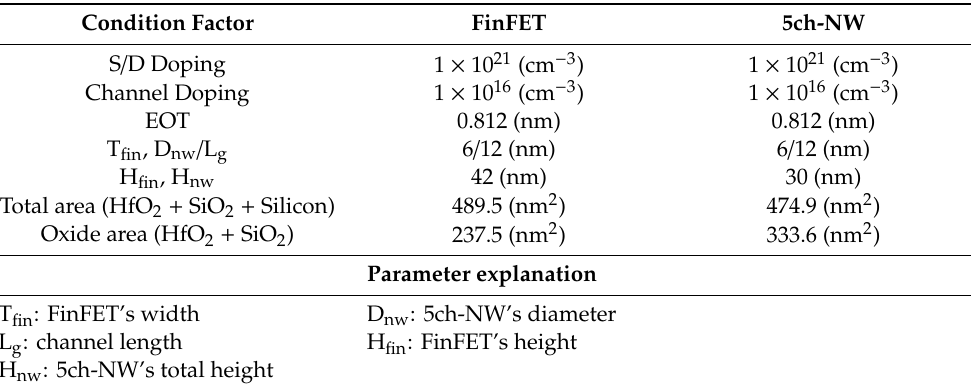
Table 1. Design specifications of the FinFET and 5ch-NW.